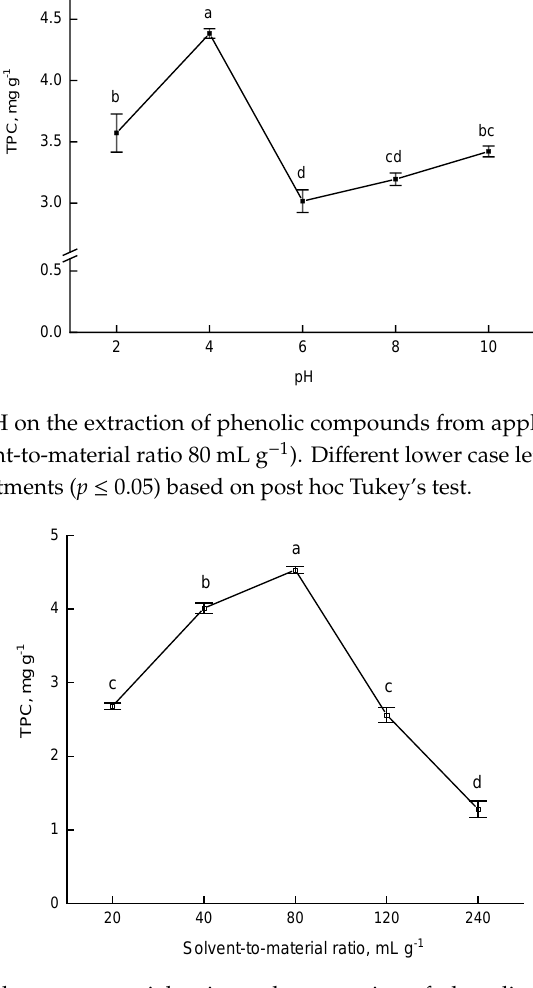
Figure A3. Effect of solvent-to-material ratio on the extraction of phenolic compounds from apple pomace (C(Tween 80) 1%, time 60 min, pH 4). Different lower case letters indicate significant differences among treatments ( p ≤ 0.05) based on post hoc Tukey’s test.